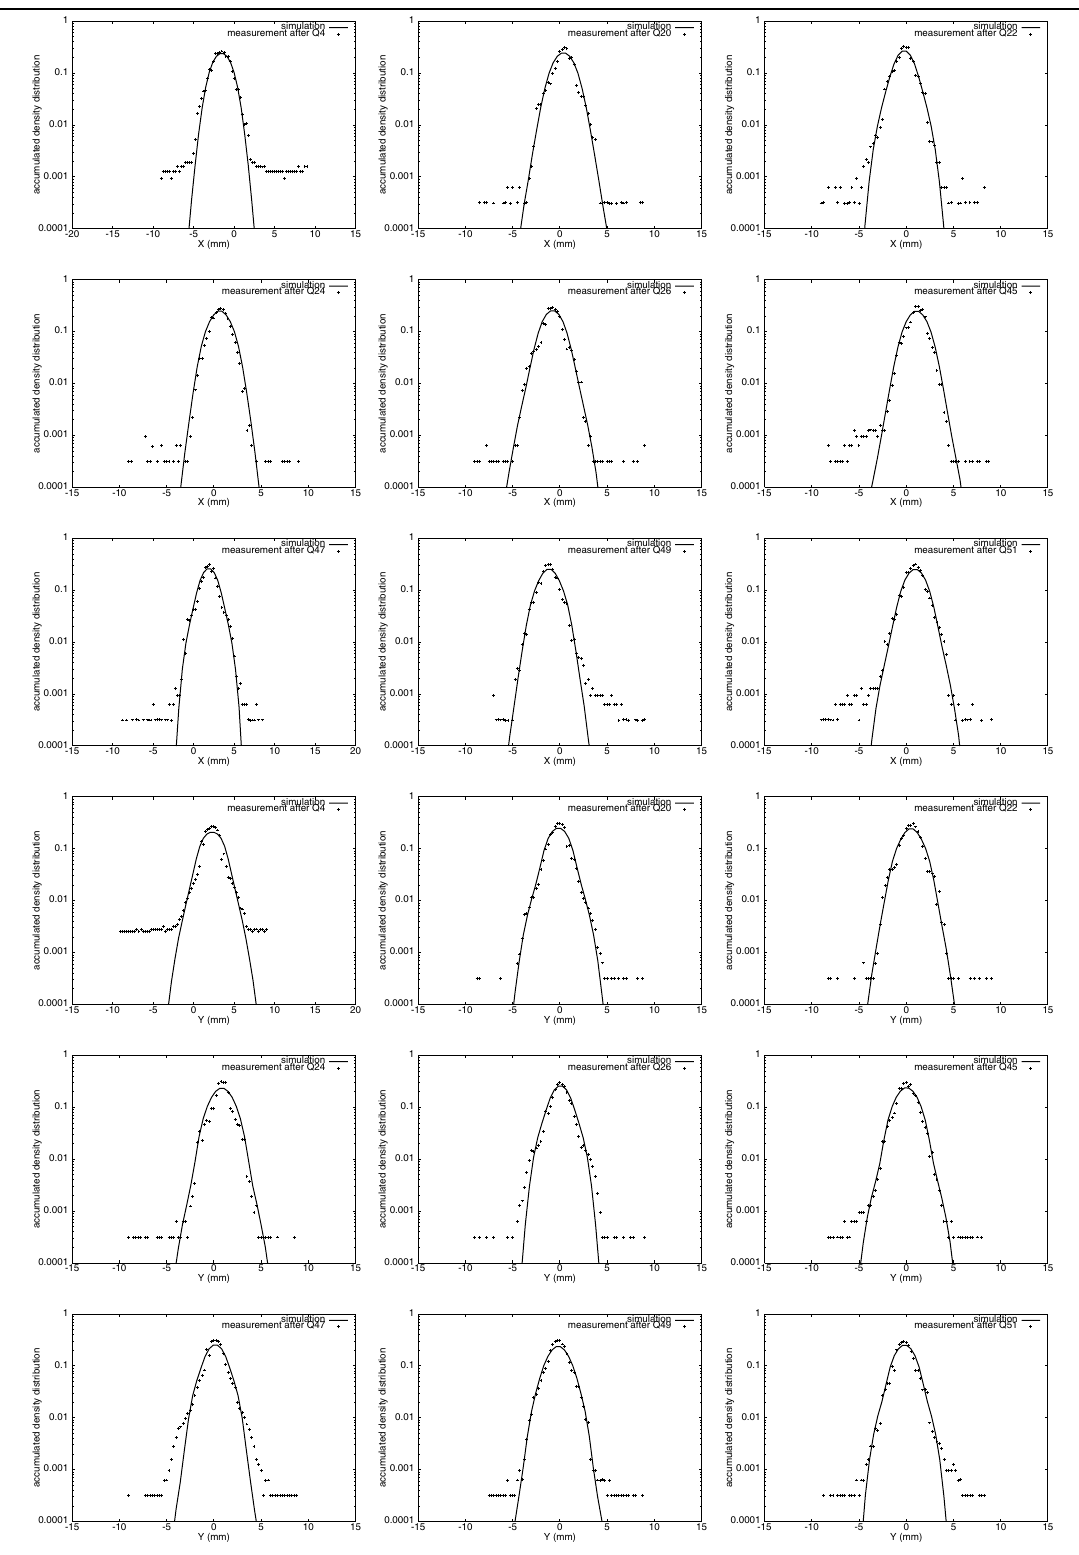
FIG. 5. X and y density distribution from simulation using initial Gaussian distribution and from measurements at 75 mA matched case. The first nine plots correspond to the nine x profiles and the second nine plots correspond to the nine y